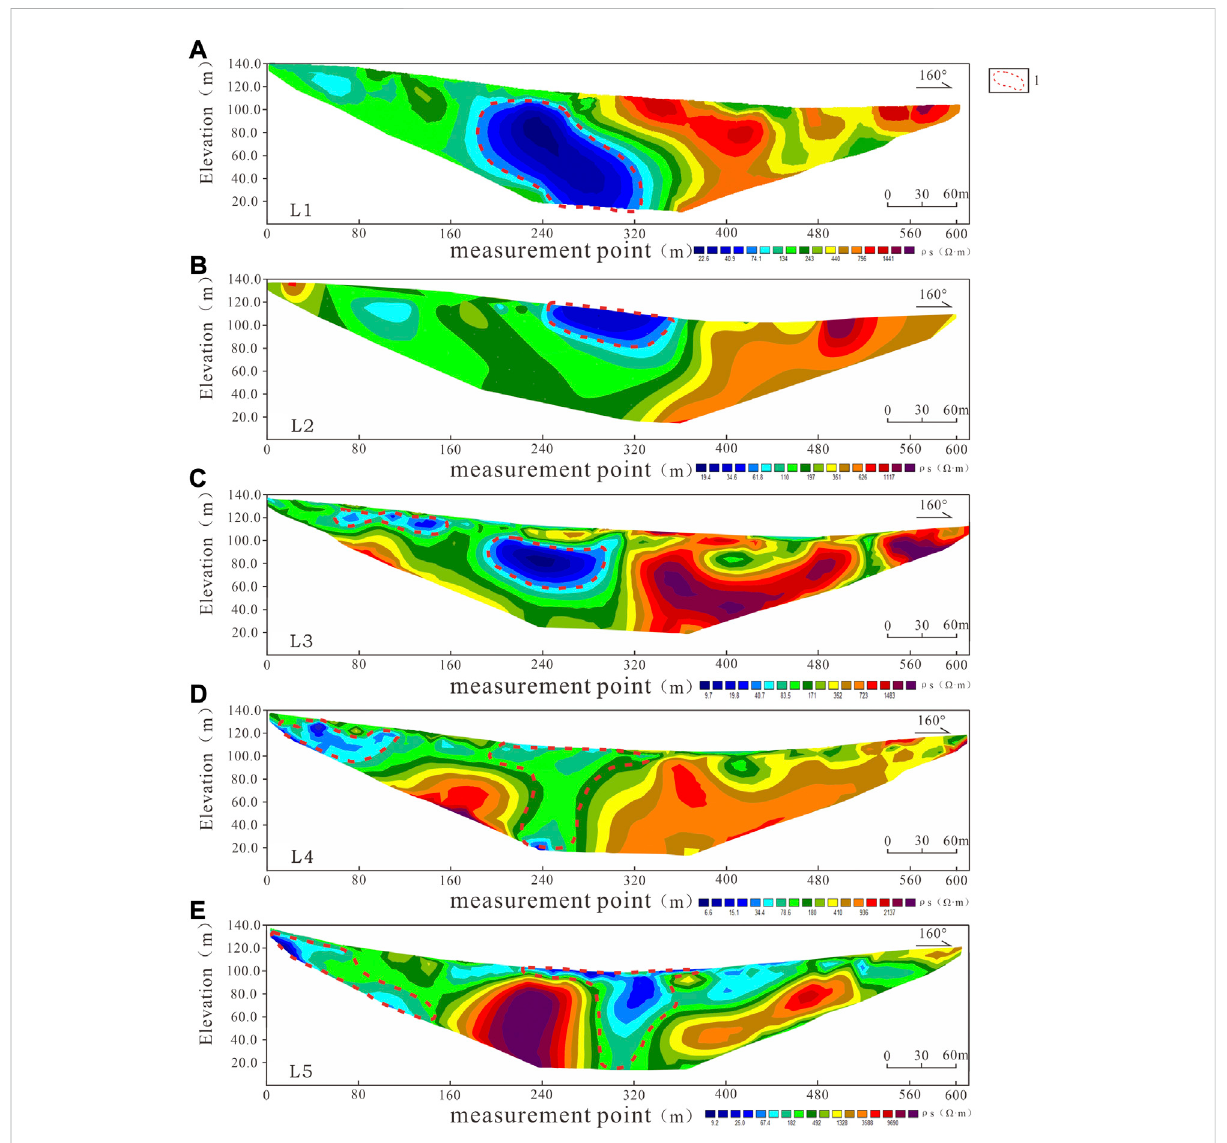
FIGURE 7 Geophysical inversion section (lines L1 – L5, A – E ) of the high-density resistivity method. 1, inferred scope of